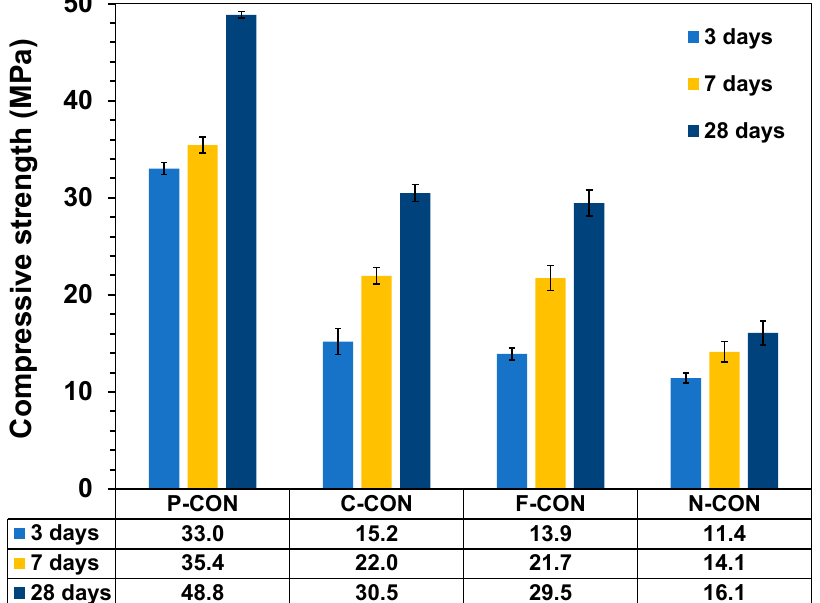
Figure 4. Compressive strengths of hardened concrete samples.